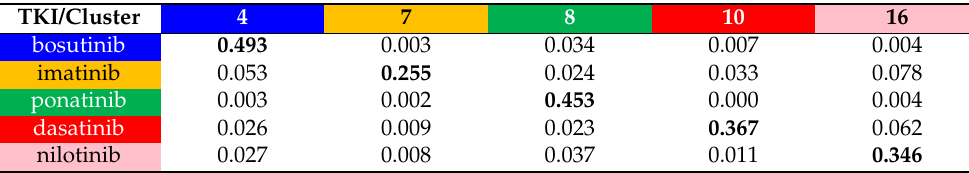
Table A1. Term frequency of each TKI within each cluster. Color coding corresponds to the colors of clusters in the cluster plot from Figure 4. Maximum frequency across all clusters is indicated with boldfaced